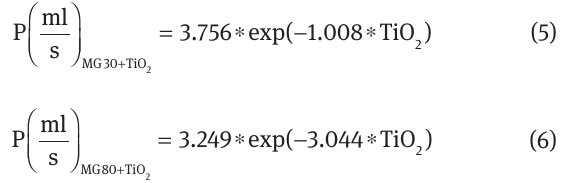
percent in recycled glass-based 2